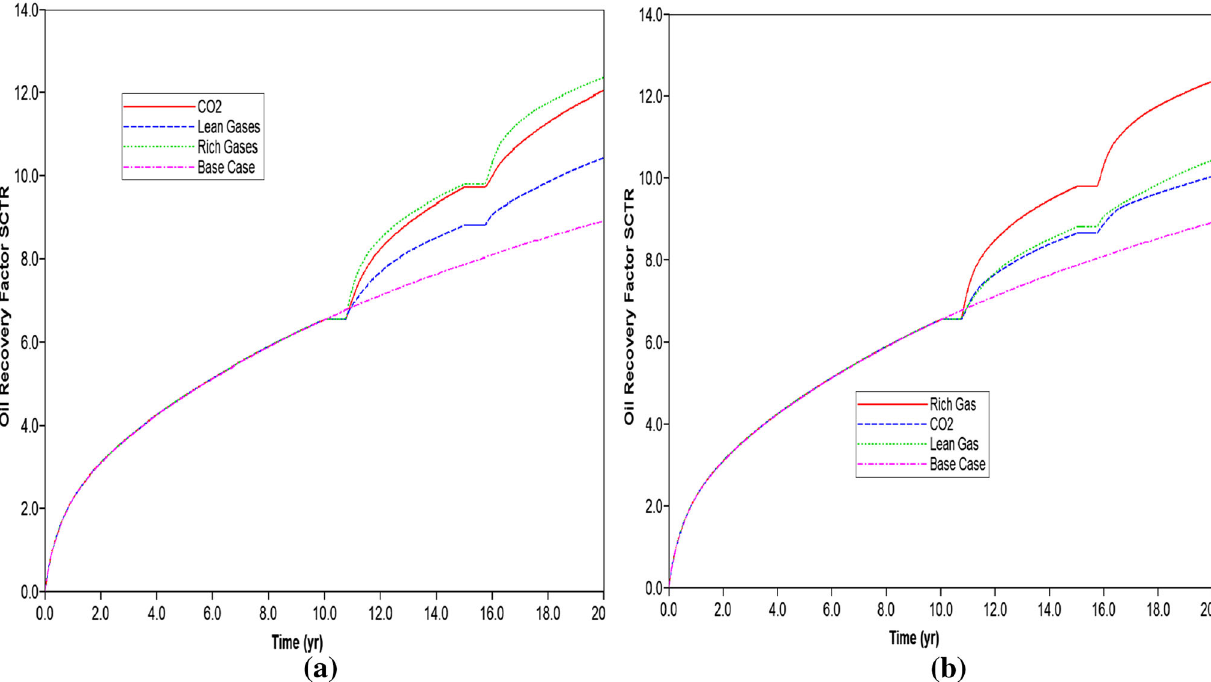
Fig. 15 Effect of the injected gas on oil viscosity (molar diffusion mechanism is OFF). a Natural gas, b CO 2